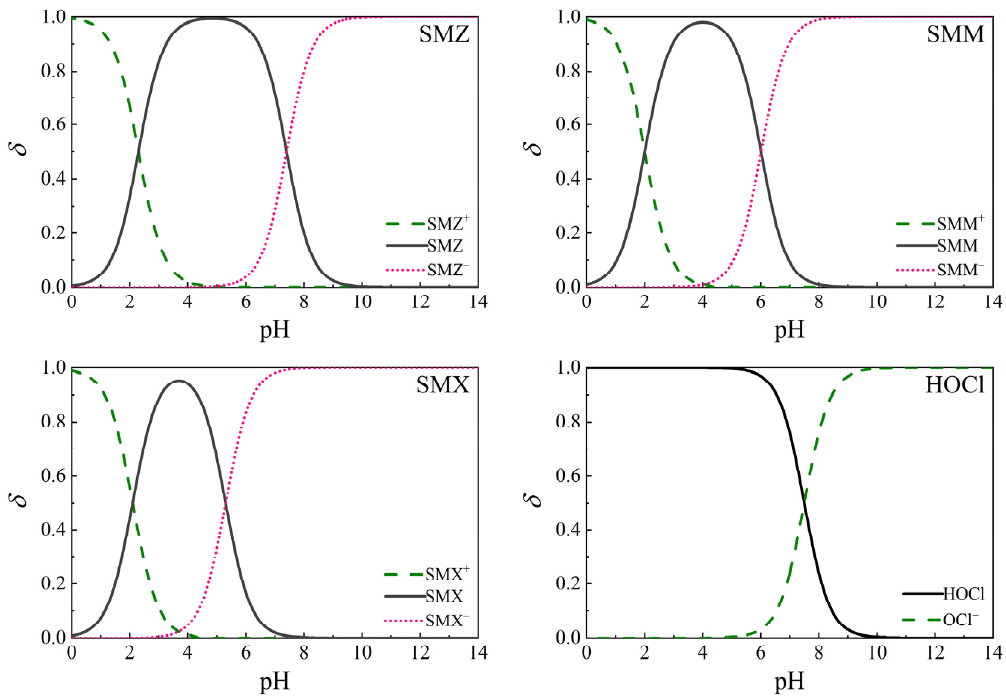
Figure A1. Distribution coefficients ( ∂ ) of sulfonamides (“+”, no mark, and “–” represent cationic, neutral, and anionic species, respectively) and HOCl at different pH. SMZ: pKa = 2.3, 7.4; SMM: pKa = 2.0, 6.0; SMX: pKa = 2.1, 5.3; and HOCl: pKa = 7.5. T = 25 °C.